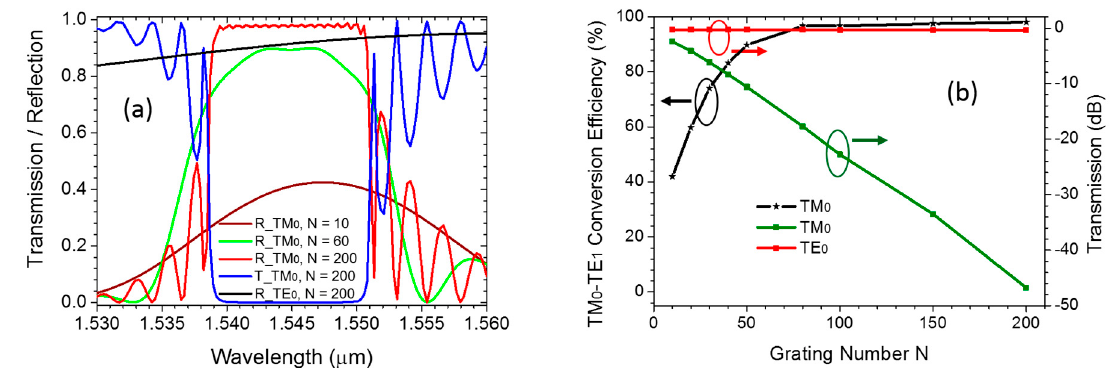
Figure 5. ( a ) The transmission and reflection spectra of linearly tapered MWG with different N. ( b ) TM 0 –TE 1 conversion efficiency as a function of grating number N at 1.546 μ m.